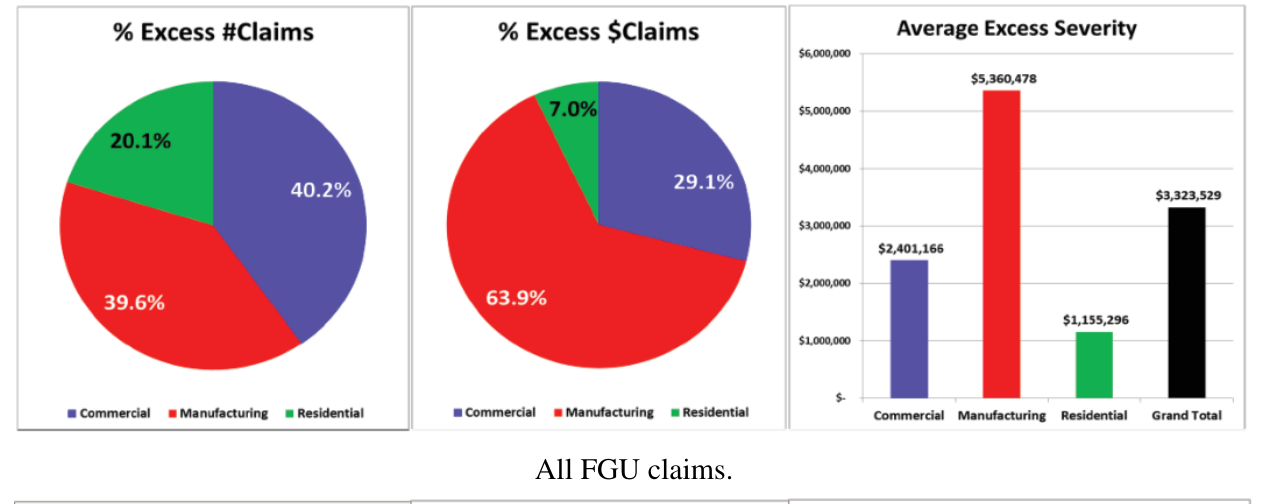
Figure 1. Claims breakdown by Occupancy Level 1 and by excess FGU above different